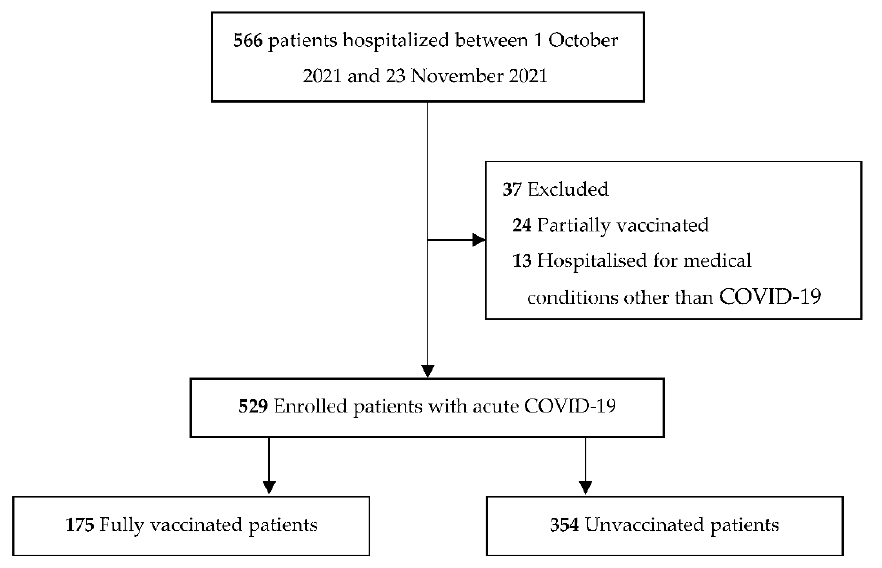
Figure 1. Flow diagram.